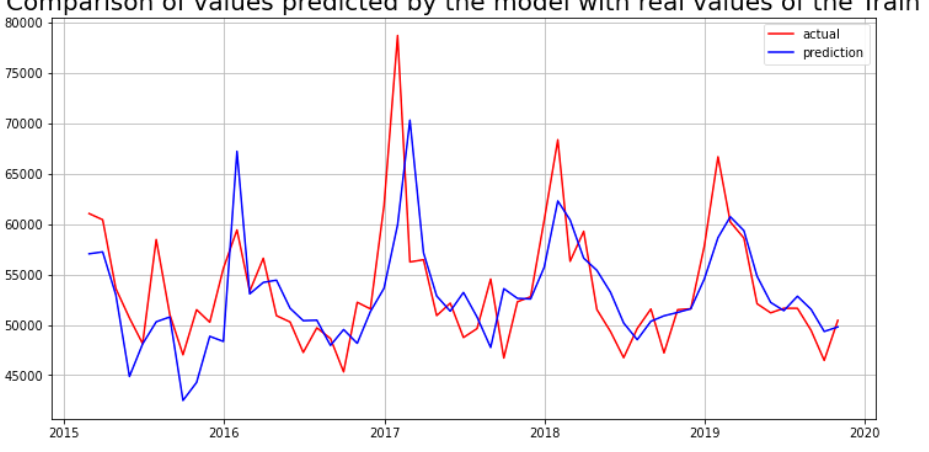
Figure 13. Comparison of the train with model